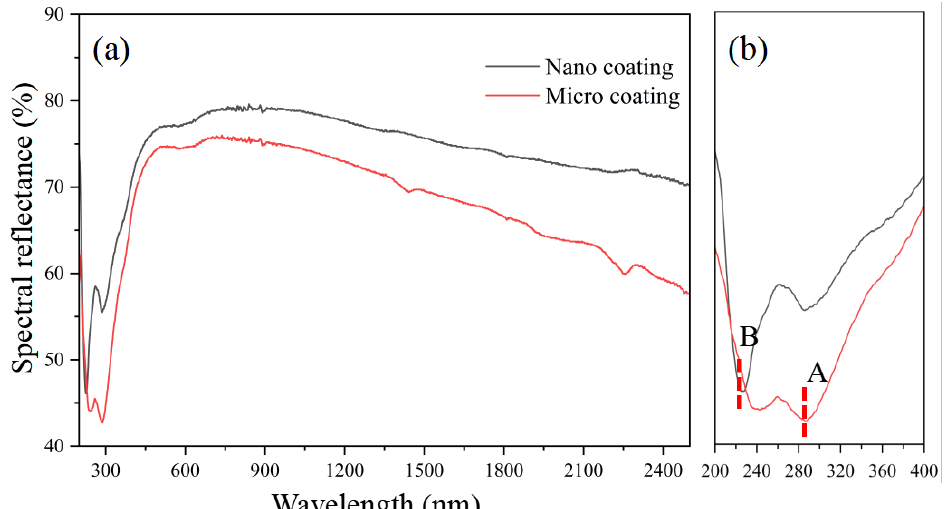
Figure 9. Reflectivity spectra of Al 2 O 3 coatings in the wavelength range of ( a ) 200-2500 nm and ( b ) 200-400 nm.